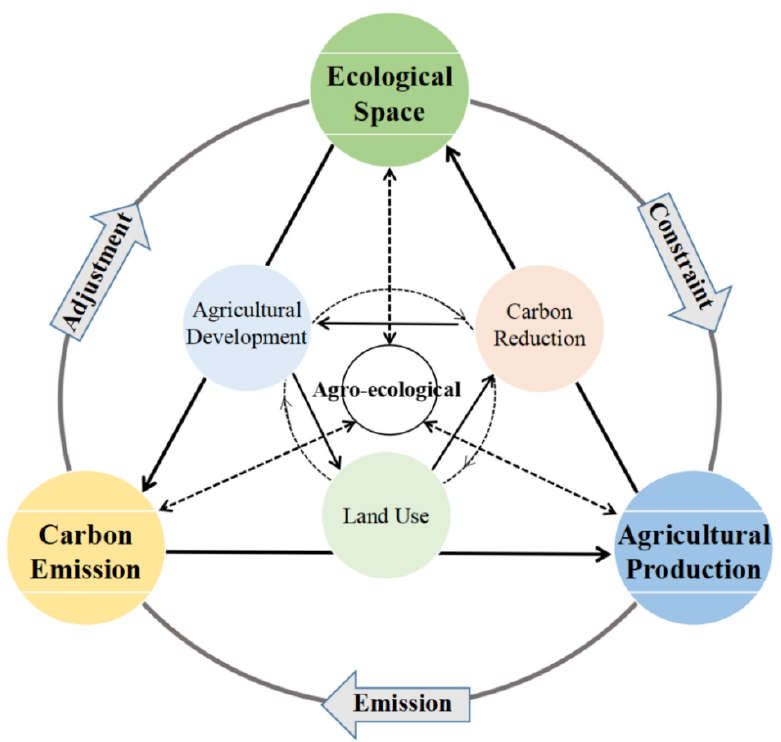
Figure 2. Theoretical framework of “ecological space–agricultural production–carbon emission”.